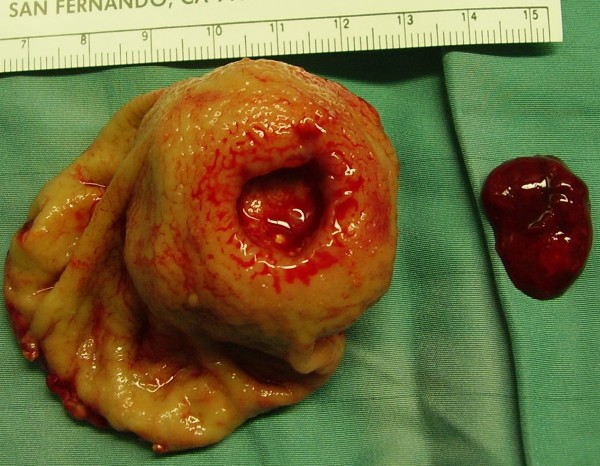
Surgical specimen of a jejunal GIST: the blood clot placed on the right side revealed the tumor causing the mucosal ulceration.